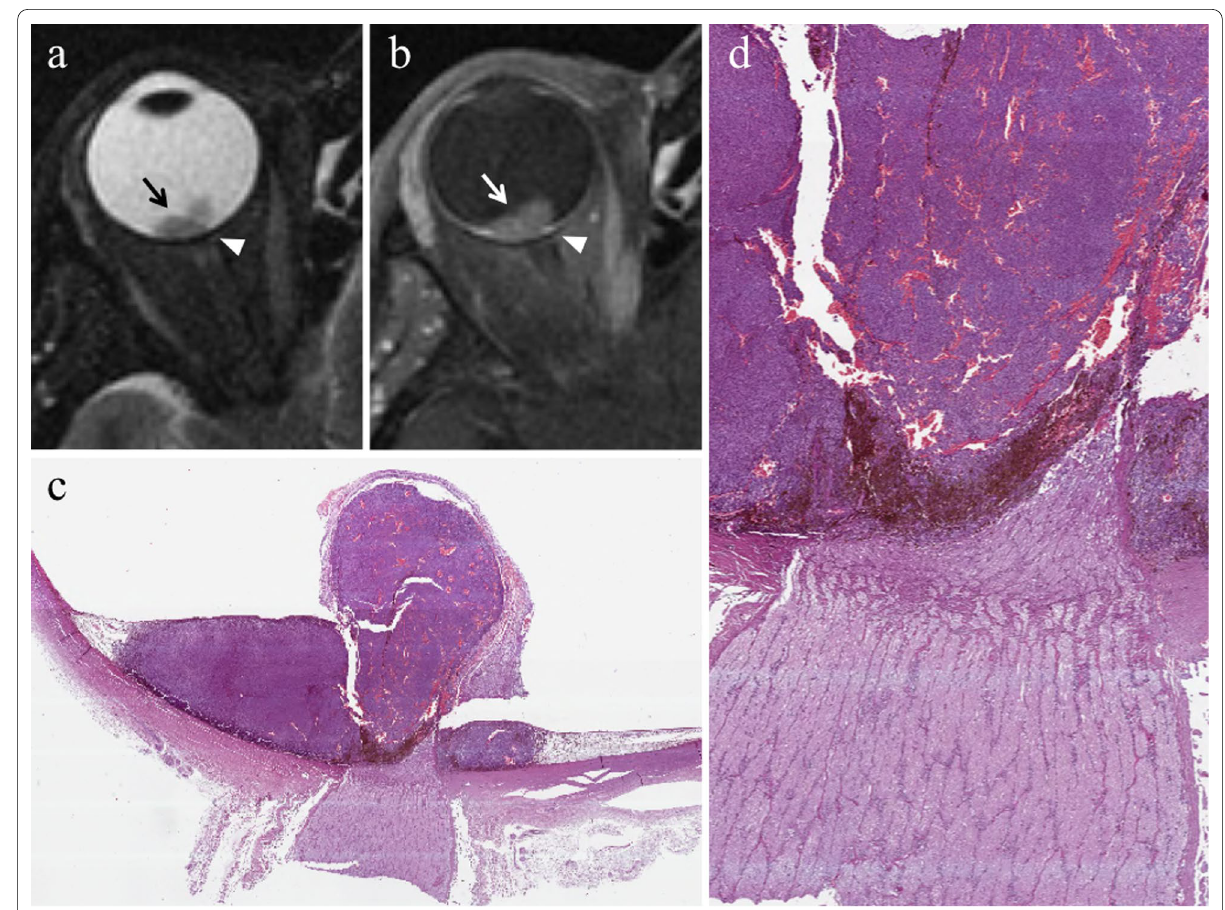
Fig. 3 A 55-year-old woman with a choroidal melanoma of the right eye infiltrating the optic disc. Axial ( a ) T2-weighted turbo spin-echo STIR and ( b ) contrast-enhanced fat-suppressed T1-weighted images demonstrate an intraocular lesion along the posterior aspect of globe (white arrows), infiltrating the optic disc (white arrowheads). c On low magnification, histological examination shows a strong overlap with MR imaging: a poorly pigmented mass located in the posterior segment of the eye, at the level of the optic disc (H&E, original magnification 25 confirms the MR findings, demonstrating an early infiltration of the emergence of the optic nerve by the melanoma (H&E, original magnification 50 ×